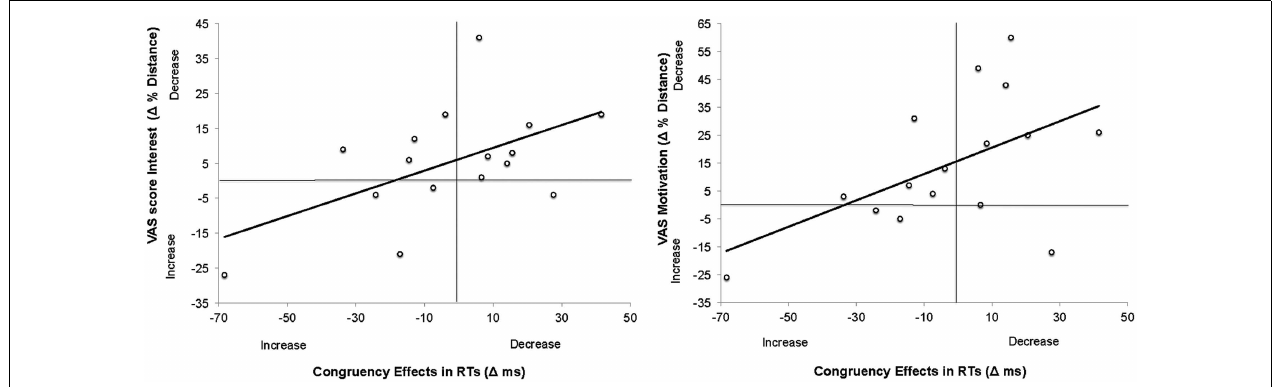
in pupil sizes.This is because the raw scores onVAS denoted the distance from the leftmost extreme (positive) to rightmost extreme (negative). Therefore, the smaller the numbers in raw scores, the more positive the state. Changes in congruency effects were calculated as Congruency Effect in RT/Error rate Block1 − Congruency Effect in RT/Error rate Block2 . Positive values denote decrease in congruency effects across